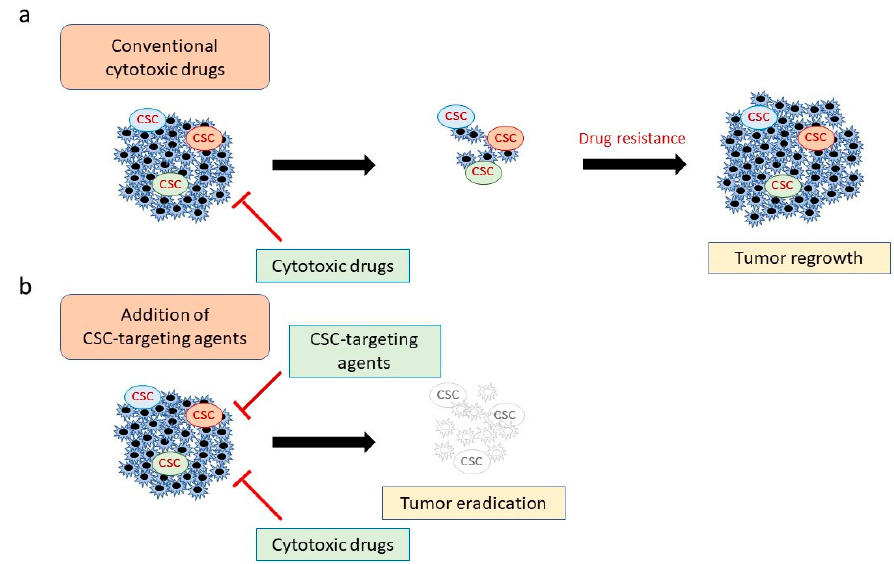
Figure 1. Combining conventional cytotoxic drugs with cancer stem cell (CSC)-targeting agents. ( a ) Although chemotherapeutic and molecular-targeted drugs can attack most cancer cells, CSCs can evade these agents, leading to tumor regrowth. ( b ) Combination therapy with CSC-targeting agents and conventional drugs is predicted to be more e ff ective because it eliminates both CSCs and non-CSC tumor